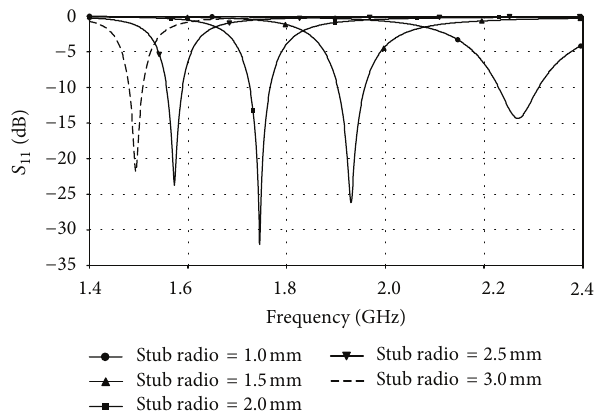
Figure 4: 𝑆 11 parameter for a fixed length stub and different radii.